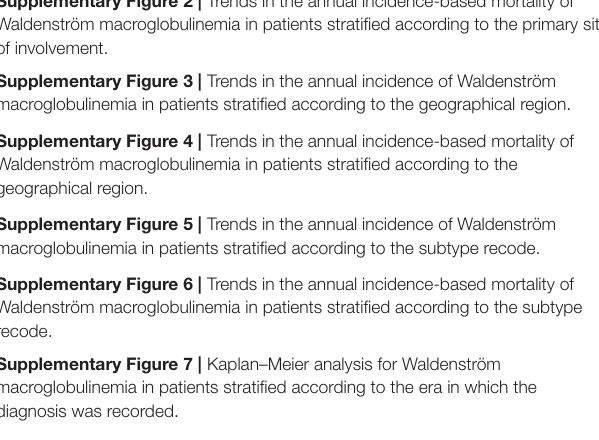
Supplementary Figure 1 | Trends in the annual incidence of Waldenström macroglobulinemia in patients stratified according to the primary site of involvement.